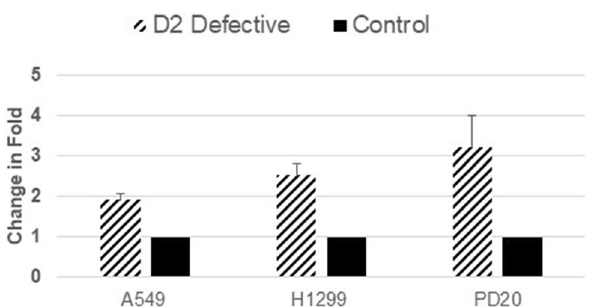
Figure 3. Evaluation of miRNA-200C expression with TaqMan microRNA real time PCR analysis in the FANCD2 defective and control cells. FANCD2 defective cells H1299D2D, A549D2D and PD20RV as well as matched control cells H1299E, A549E and PD20D2 cells were cultured and total RNA samples were isolated. Quantitation of miRNA expression was carried out using TaqMan real time polymerase chain reaction (PCR). Primers and probes used for the real time PCR analysis were obtained from Applied Biosystems (Foster City, CA). Real-time PCR was carried out in a 96-well plate using a Bio-Rad CFX96 system. Each sample was done in triplicate and each reaction was repeated at least once to ensure reproducibility. Resulting data were quantified and normalized using RNU48 as